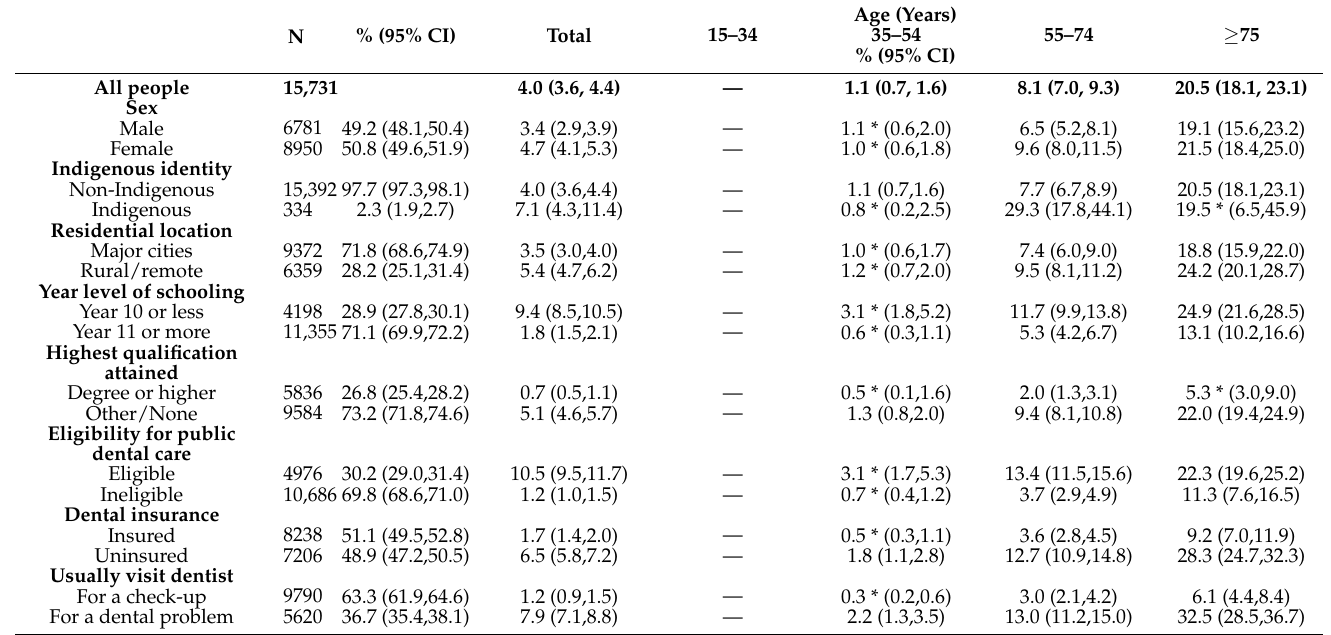
Table 6. Proportion of adults with complete tooth loss in the Australian